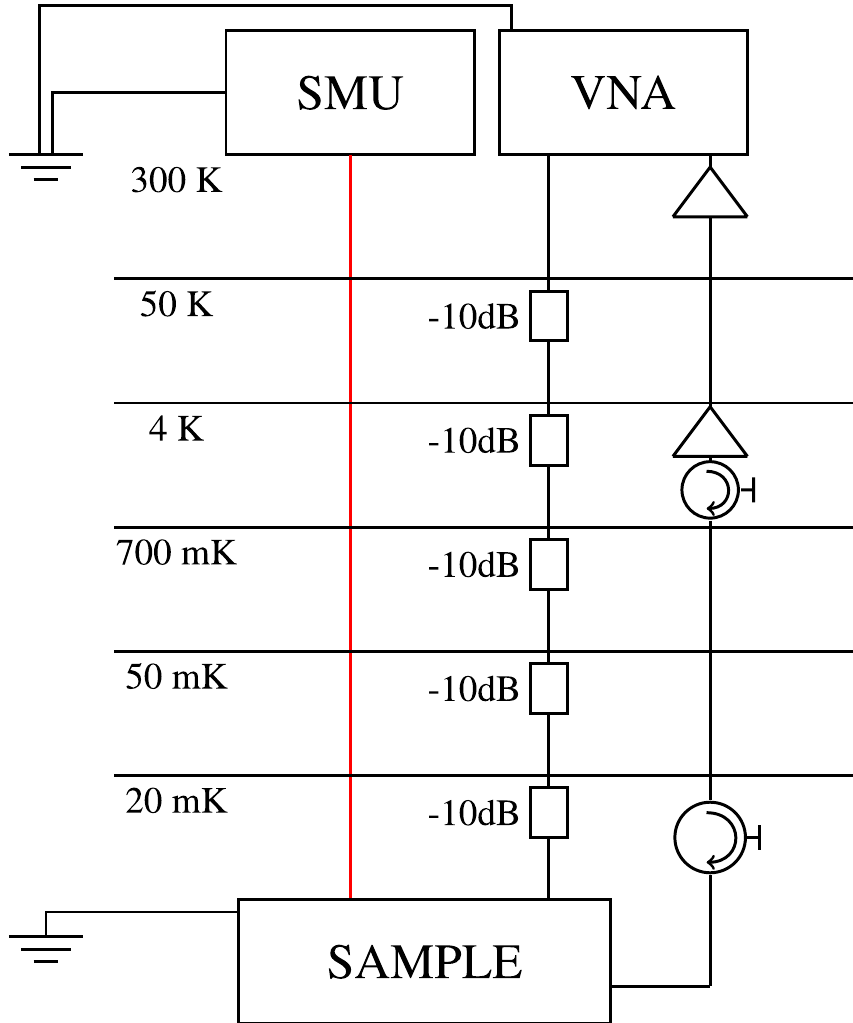
Figure 2. Electrical schematic of the experimental setup. The red line represents a Thermocoax cable. The two grounds represent the same microwave ground, to which the direct current supply, the VNA, and the ground plane of the sample are